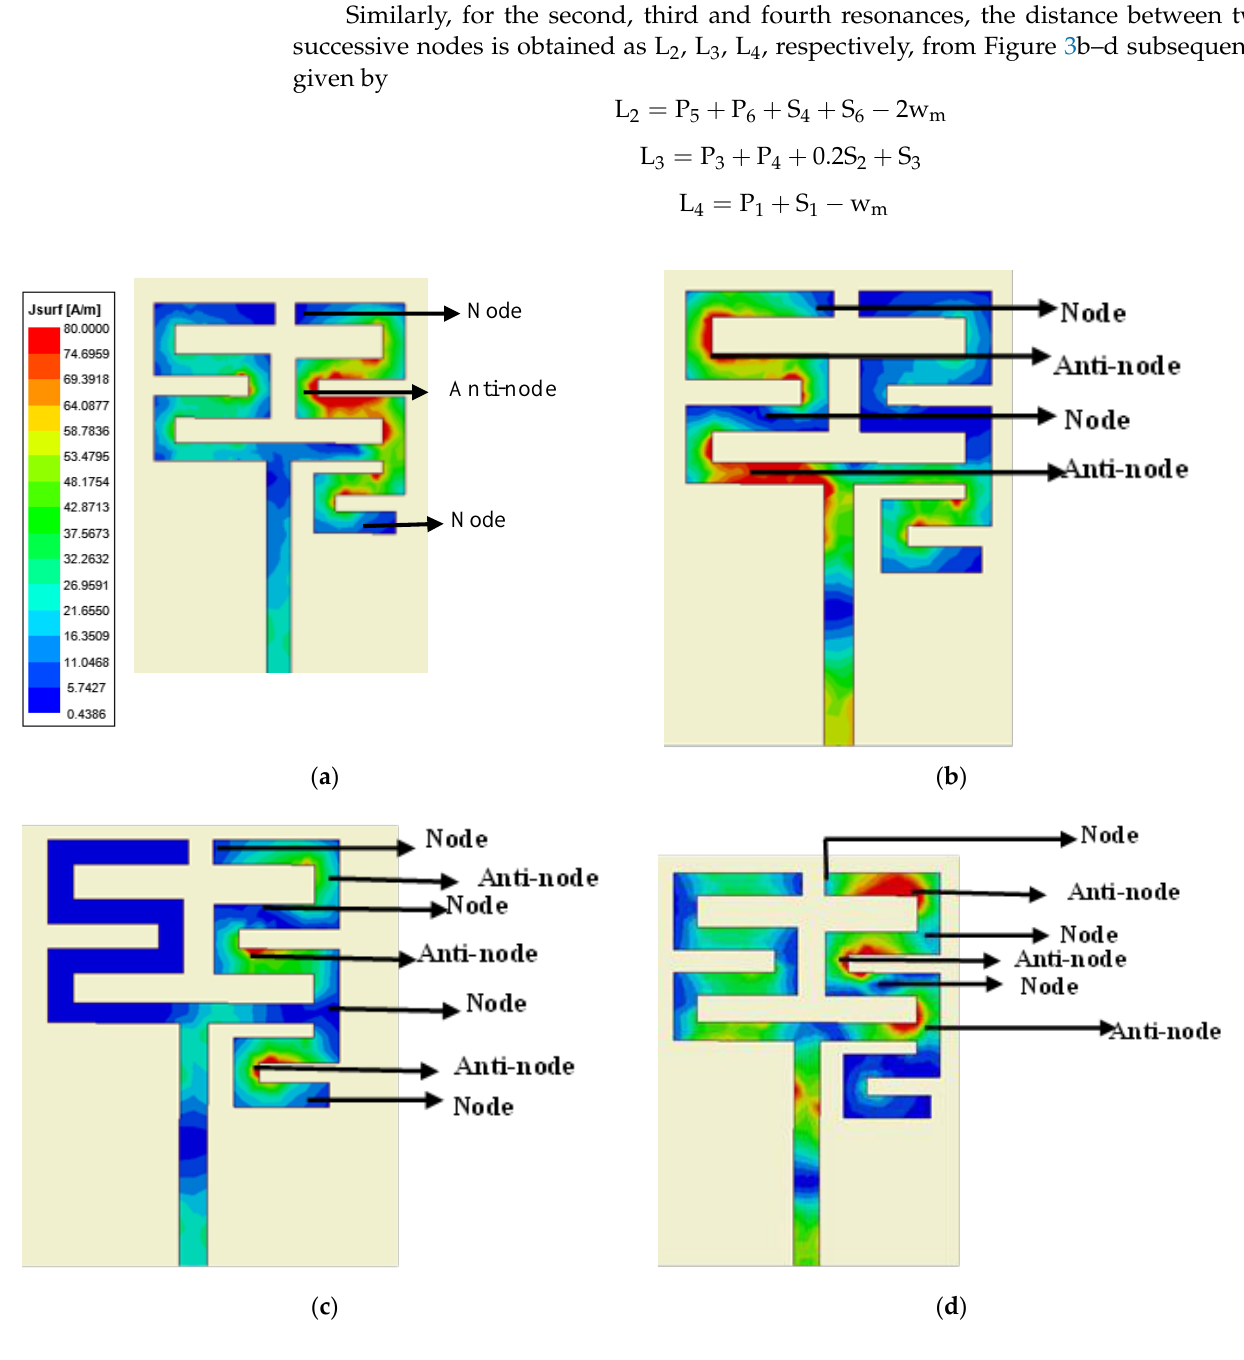
Figure 3. Simulated current distribution at ( a ) 1st resonance, ( b ) 2nd resonance, ( c ) 3rd resonance, ( d ) 4th resonance of single unit quad band meander-line antenna.